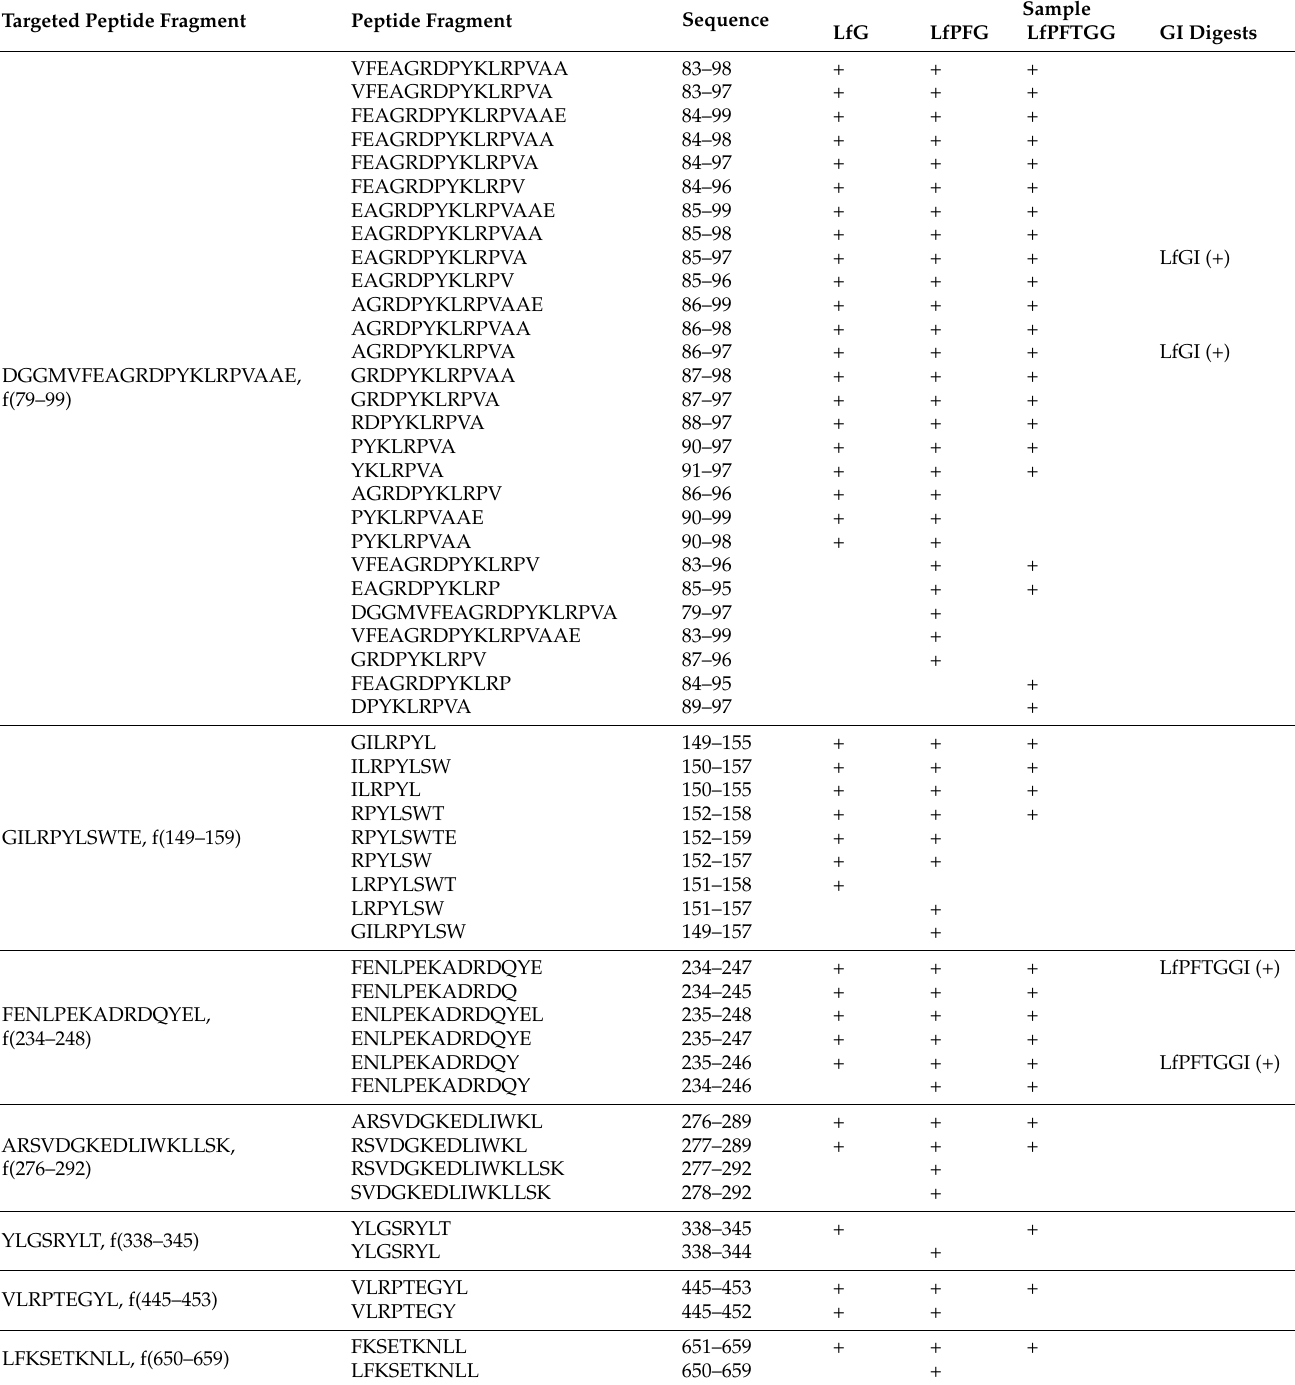
Table 2. Active peptide fragments in the digests of bLf, LfPF complex, and LfPFTG complex produced by in vitro gastrointestinal digestion at pH